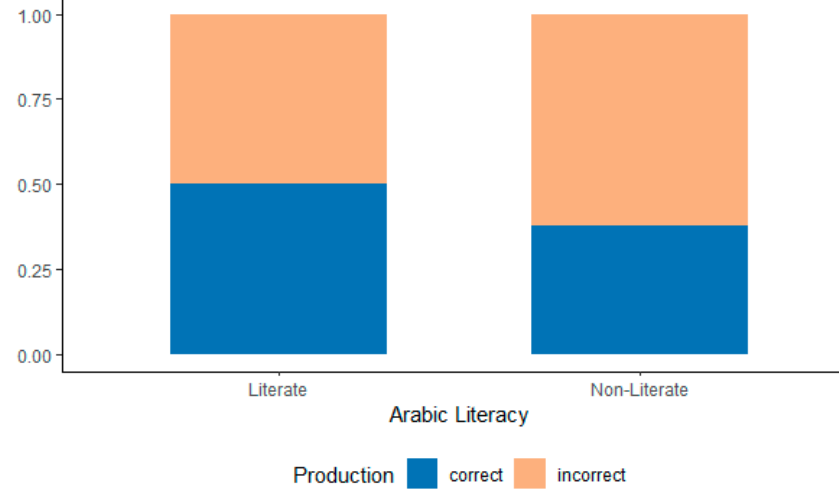
Figure 4. Percent accuracy in the productions of the target Arabic consonants by literate and non- literate FDHs. Table 4. Percentage of modification in onset and coda consonant clusters (CC) in FDH’s productions and the modification strategy